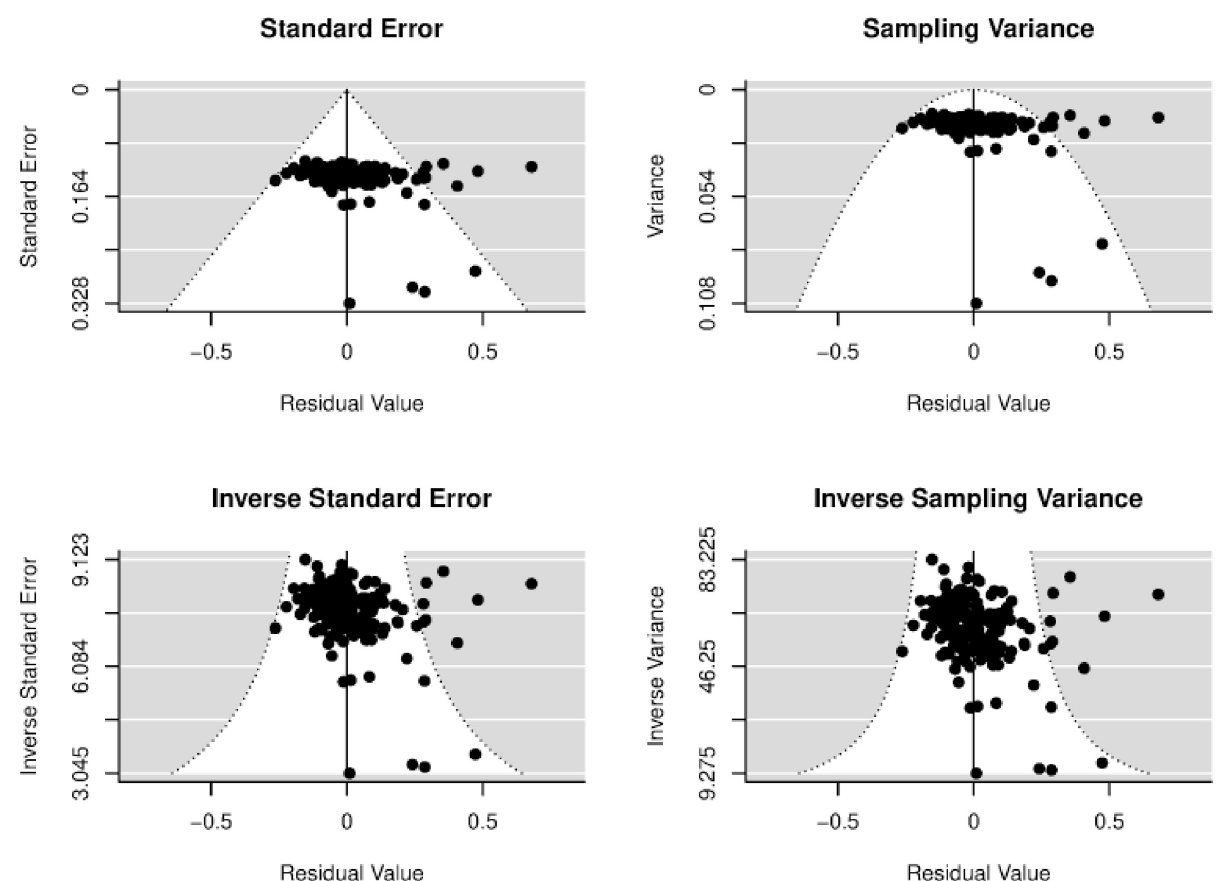
Fig 2. Funnel plot for publication